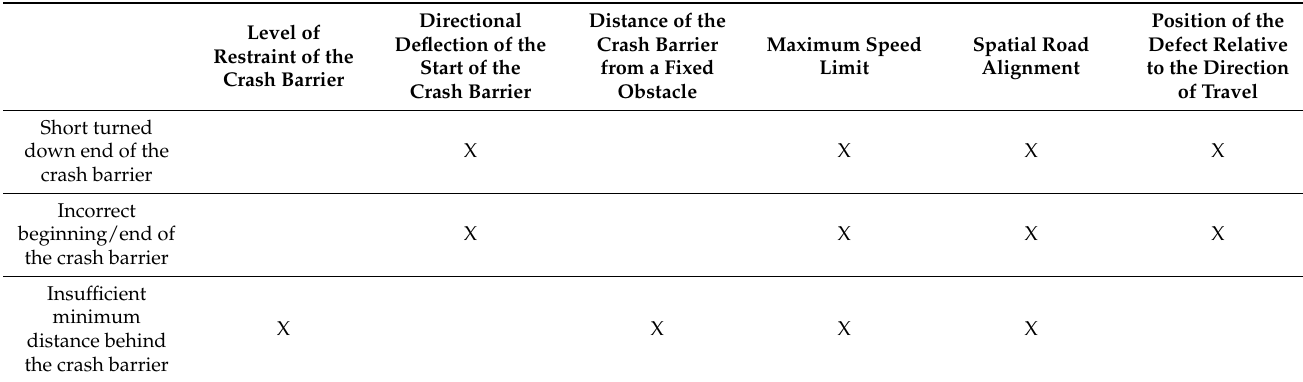
Table 1. Assigned parameters according to the type of defect.